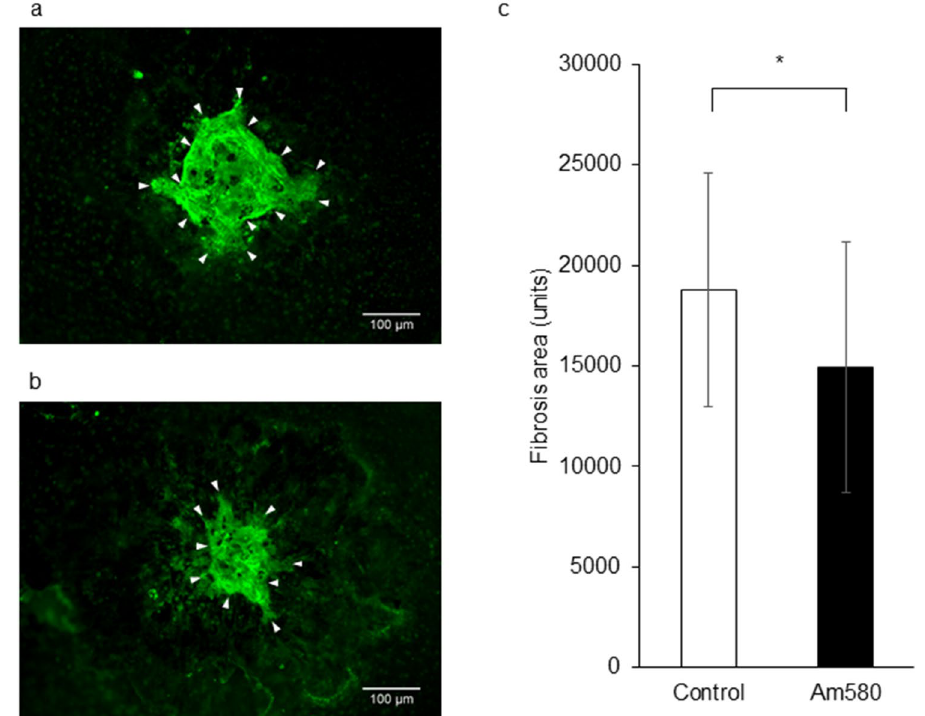
Figure 8. Inhibitory effect of an RAR-α agonist in a mouse model of subretinal fibrosis. Intravitreal injection (1 µl) of either PBS vehicle ( a ) or Am580 (50 µM) ( b ) was performed both immediately and 3 days after laser photocoagulation. Choroidal flat-mount preparations from the mice at 3 weeks after photocoagulation were subjected to immunofluorescence staining with antibodies to collagen type I (green). Arrowheads indicate photocoagulation-induced subretinal fibrosis. Scale bars, 100 µm. The area of fibrosis was measured with the use of the Measure command in ImageJ software and determined for the treated mice as mean ± s.d. values ( n = 40 laser spots per group) ( c ). * P < 0.05 (Mann-Whitney